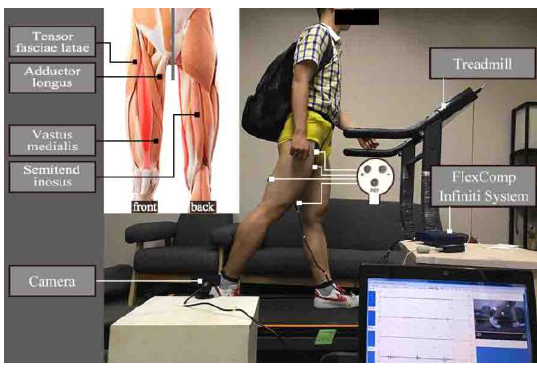
Figure 1. The experimental equipment and the placement of the four-surface electromyogram (sEMG) electrodes.